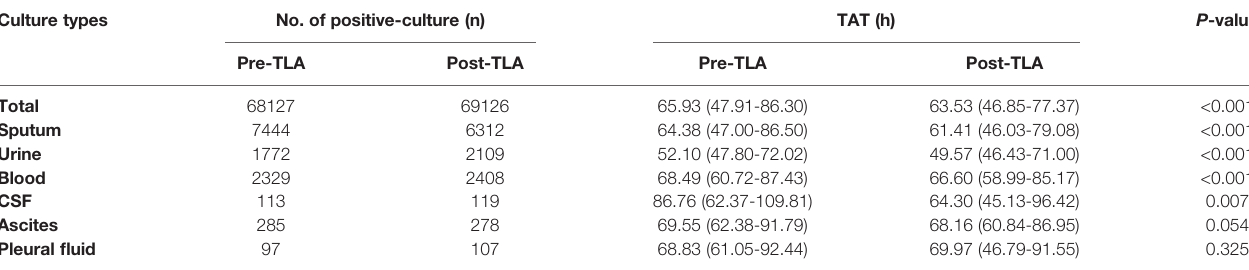
TABLE 1 | Comparison of TAT between pre-TLA and